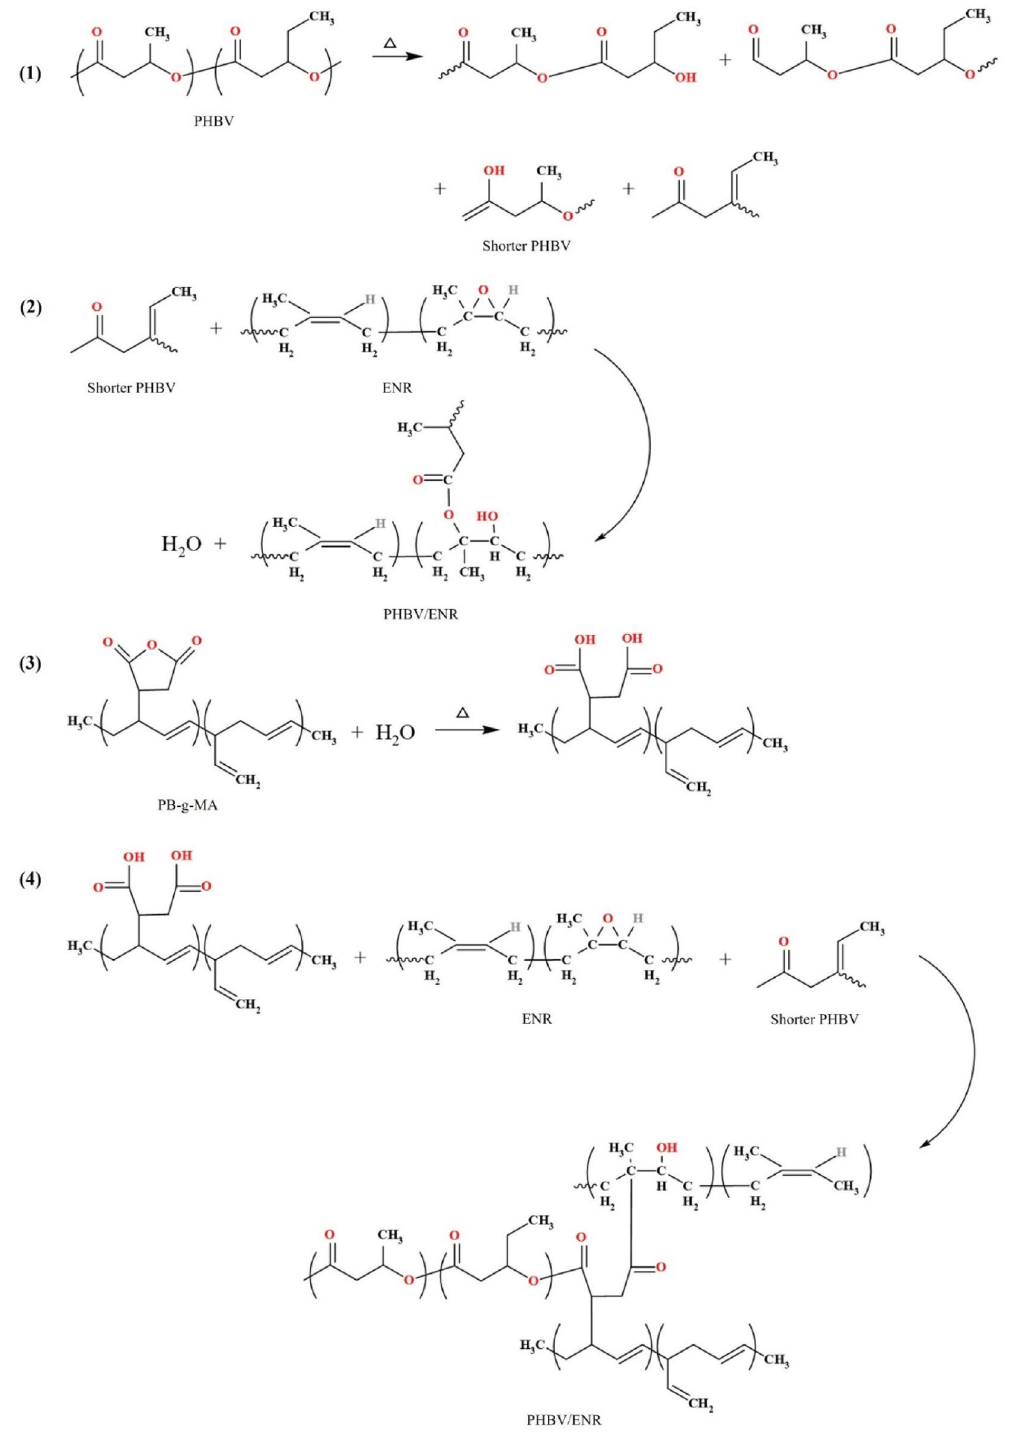
Figure 1. Schematic illustration of the proposed reactions between PHBV, ENR, and